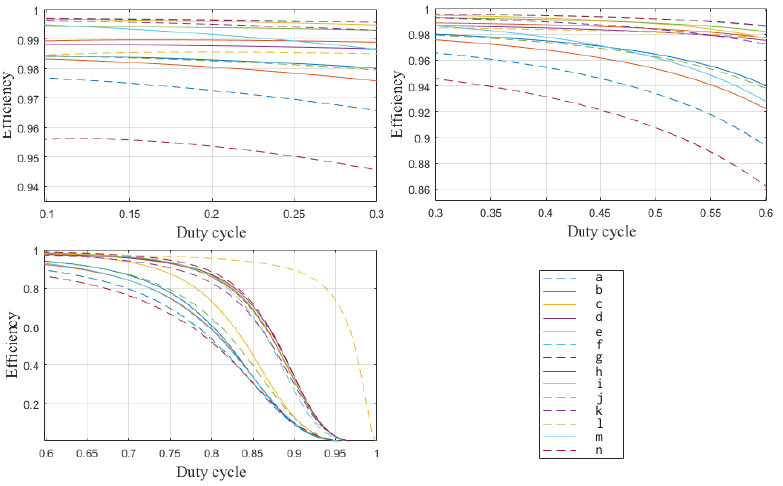
Figure 10. The efficiencies comparison: (a) proposed converter, (b) introduced topology in [18], (c) introduced topology in [19], (d) introduced topology in [20], (e) introduced topology in [21], (f) introduced topology in [22], (g) introduced topology in [23], (h) introduced topology in [24], (i) introduced topology in [25], (j) introduced topology in [26], (k) introduced topology in